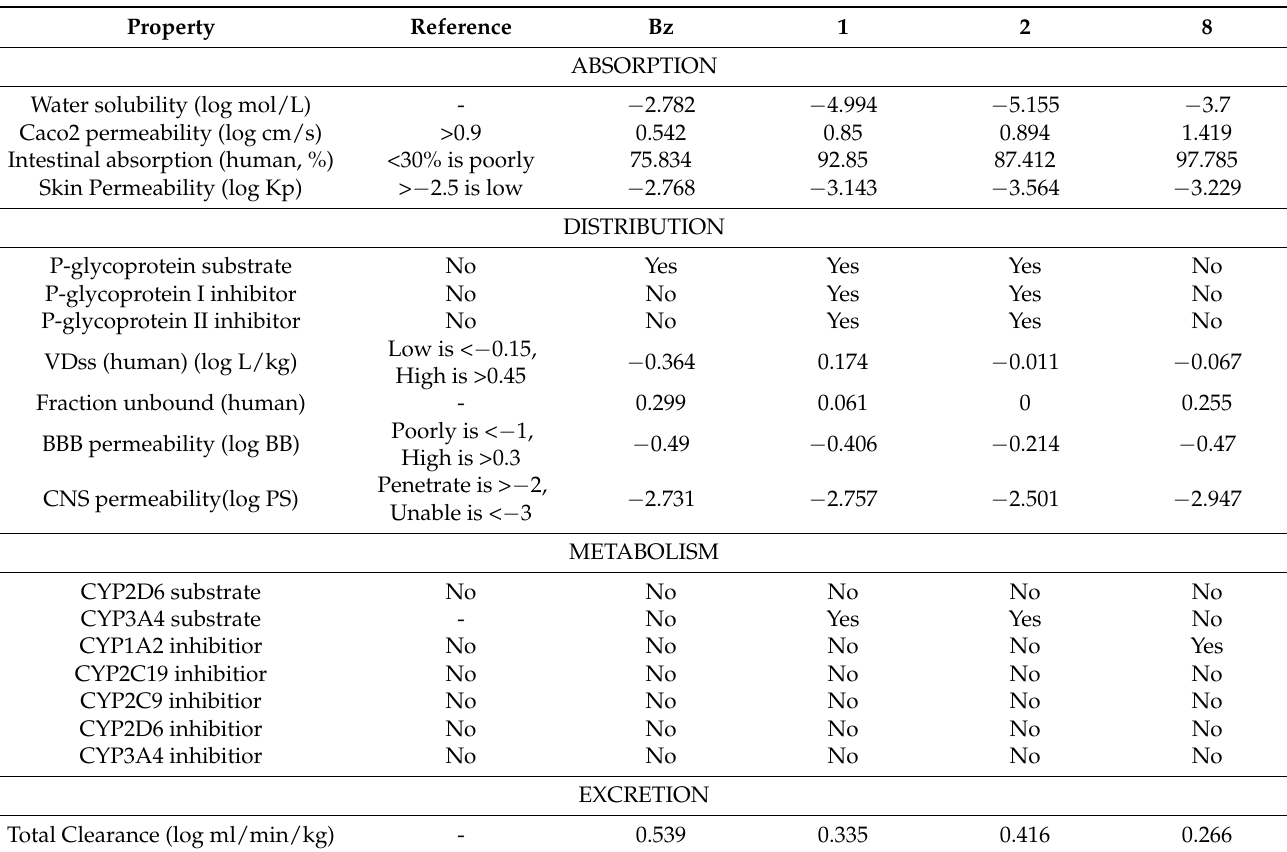
Table 6. In silico ADMET using pkCSM